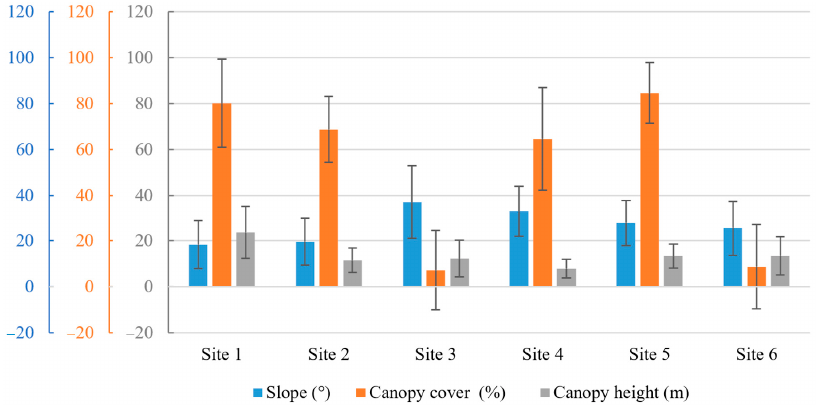
Figure 3. Statistics for the six forested sites.